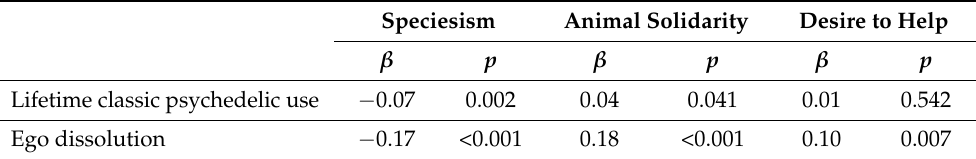
Table 1. Lifetime classic psychedelic use, ego dissolution, and human–animal relations. Speciesism Animal Solidarity